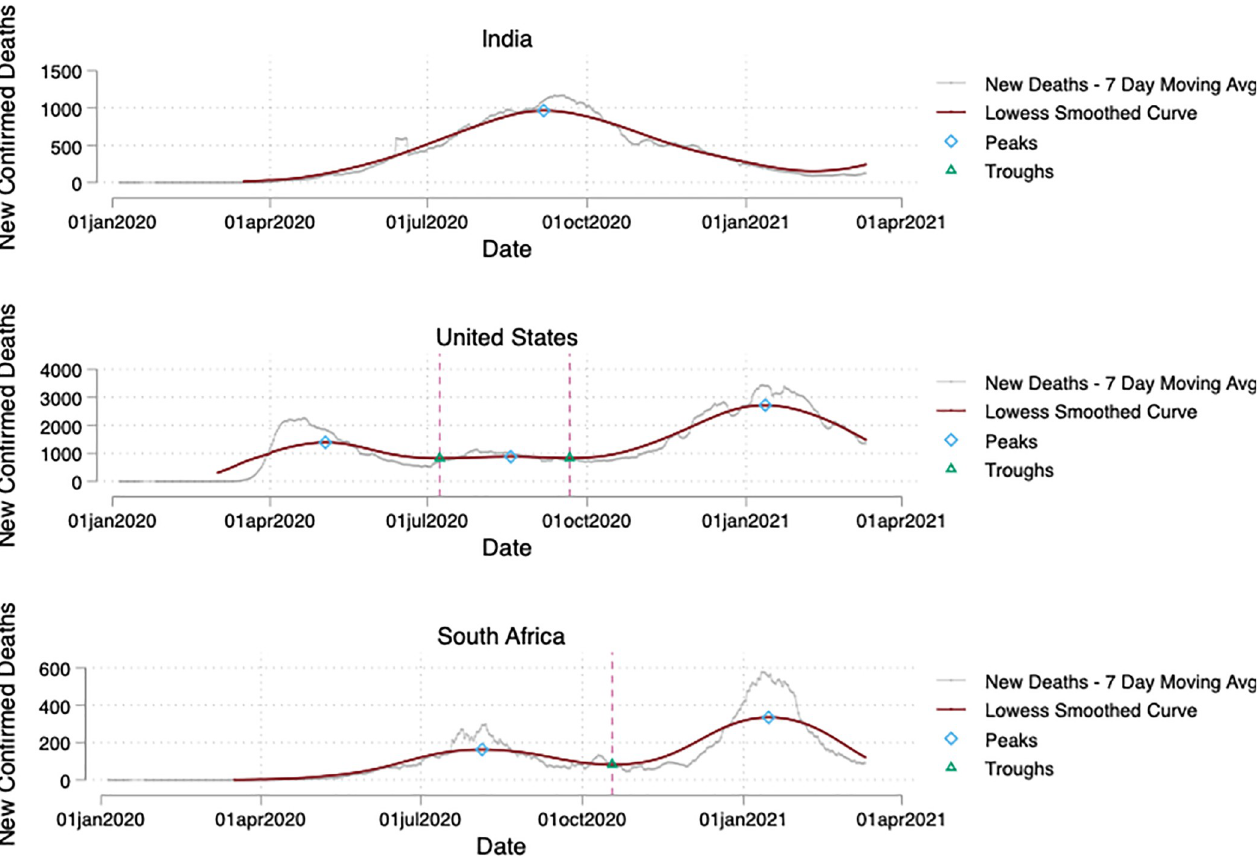
Fig 1. Identifying waves of COVID-19 in different countries. India, South Africa, and the United States exemplify the need for data-driven distinctions for enumerating waves, which occurred in different months, to different degrees and over different time horizons.